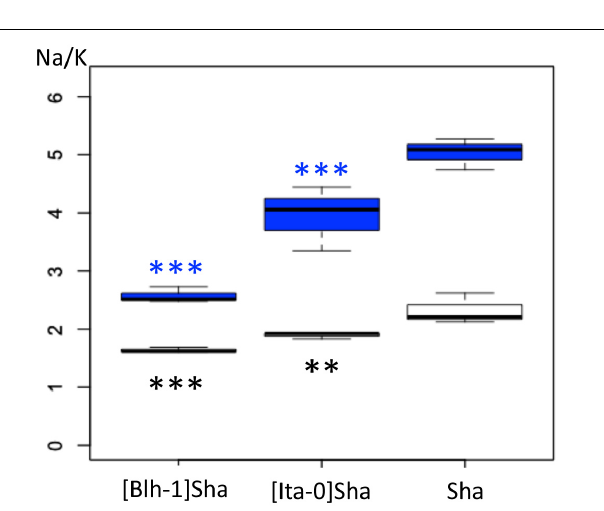
FIGURE 5 | Ratios of Na + and K + ion contents in seeds from lines with different cytoplasms associated with the Sha nucleus. Ratios of Na + and K + ion contents just after stratification (white boxplots) or after 20 h of germination (blue boxplots) measured in seeds on 100 mM NaCl. The Na/K ratios were different between the three genotypes in pairwise contrast tests. On the figure, only p -values for comparisons of the cytolines to Sha are shown, ∗∗∗ < 0.001, ∗∗ <